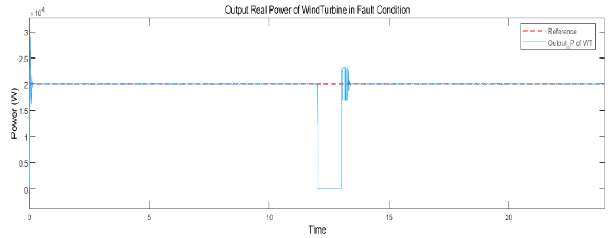
Fig. 12. Real output power of WT in switching condition